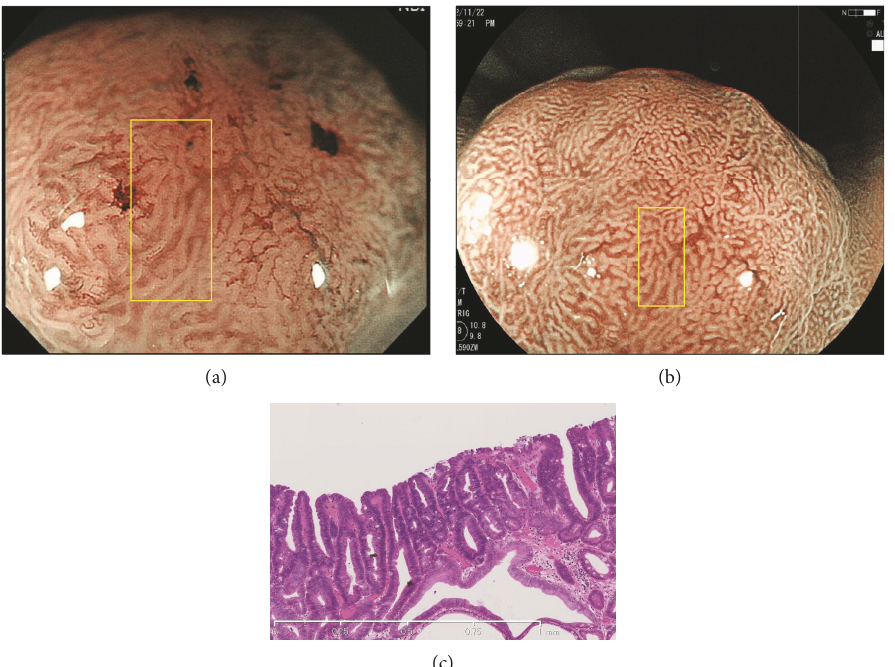
Figure 4: A well-di ff erentiated adenocarcinoma in group B. (a) ME-NBI showed an irregular MSP (yellow box). (b) ME-BLI showed an irregular MS (yellow box). (c) Histological view of the yellow box in Figures 4(a) and 4(b). The crypts were deep and straight.